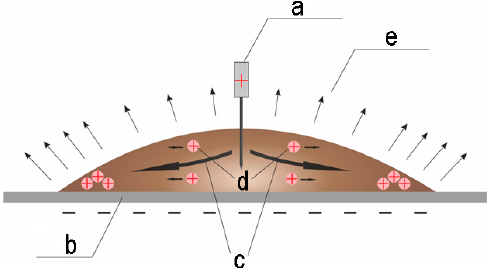
Figure 6. Schematic representation of the processes in a drop when it is dried on a negatively charged surface with a positive needle electrode. Needle electrode (a); ITO glass (b); compensation flow directions (c); nanoparticles (d); the directions of evaporation flux (e).